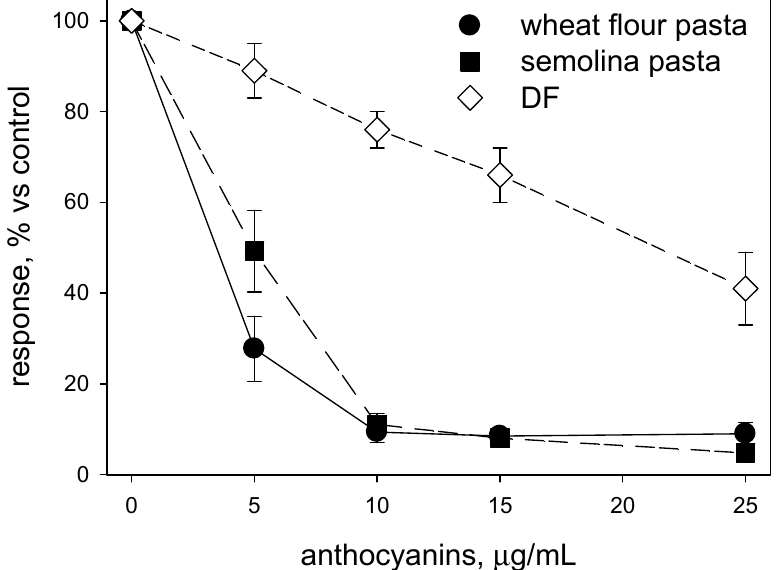
Figure 2. Immunosuppressive effects of the aqueous ethanol extracts from both types of cooked pasta and the original debranning fraction (DF) Data are presented as percent inhibition of IL1 β -stimulated expression of NF- κ B. Acid-free extracts were used in all these assays. Results are reported as averages ± SD ( n = 3).